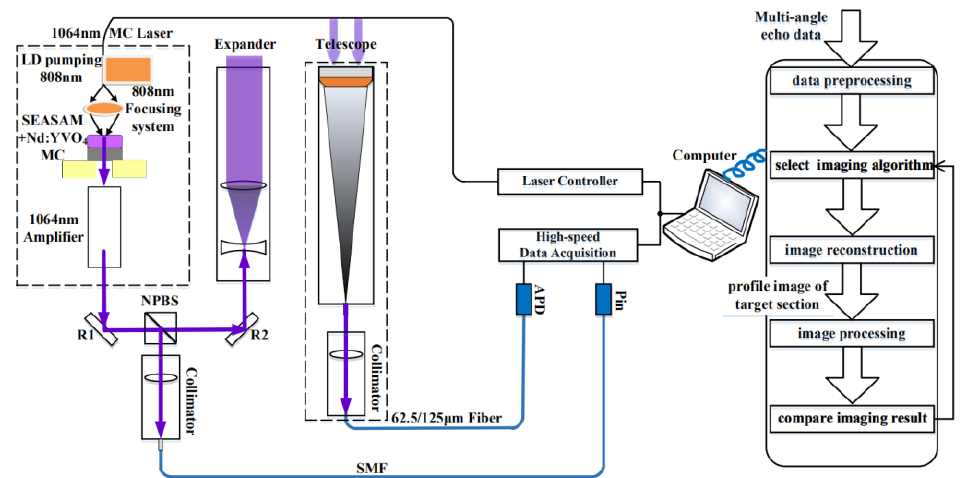
Figure 3. Schematic diagram of LRT radar prototype: R, reflector; NPBS, Non-polarizing beam splitter; APD, avalanche photodiode; Pin, positive intrinsic negative; SMF, single mode fiber; MC Laser, microchip laser.